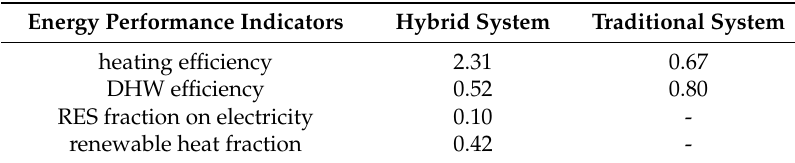
Table 5. Comparison between hybrid and traditional systems.